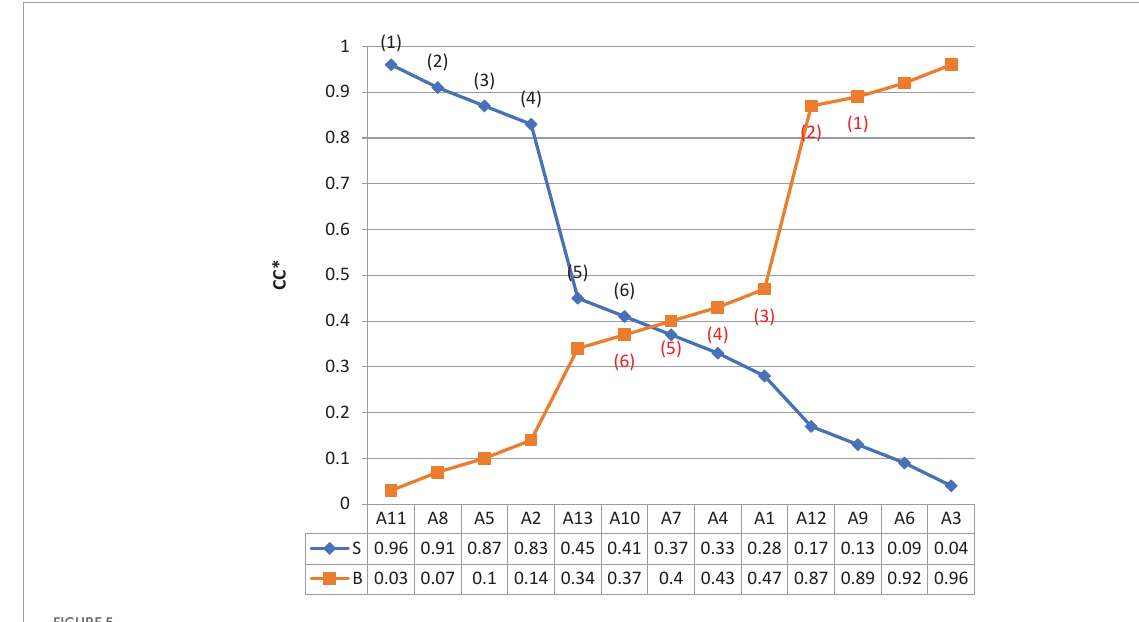
FIGURE5 Record of negotiation.